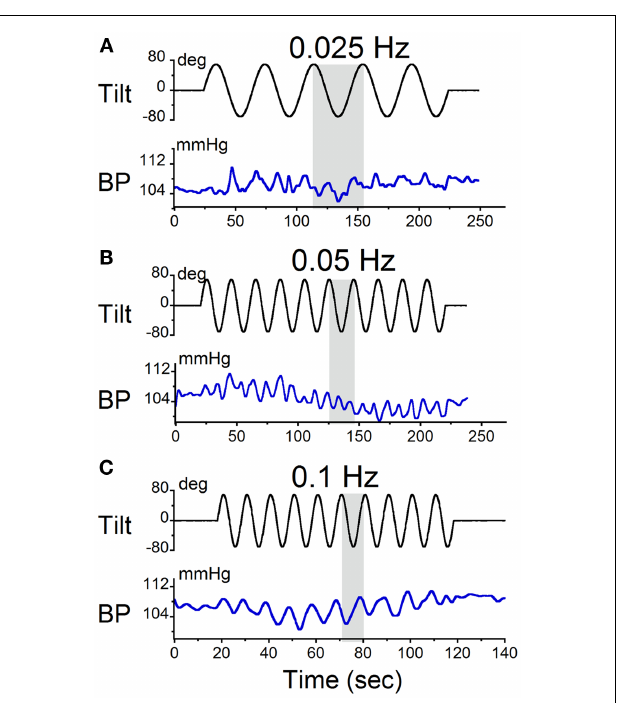
FIGURE 4 | Sinusoidal oscillations in pitch ± 70° at (A) 0.025Hz, (B) 0.05Hz, and (C) 0.1Hz .The black trace in each panel is the tilt stimulus; the blue trace is systolic BP.The gray area indicates one tilt cycle. BP oscillated at twice the stimulus frequency at 0.025 and 0.05Hz, but not at